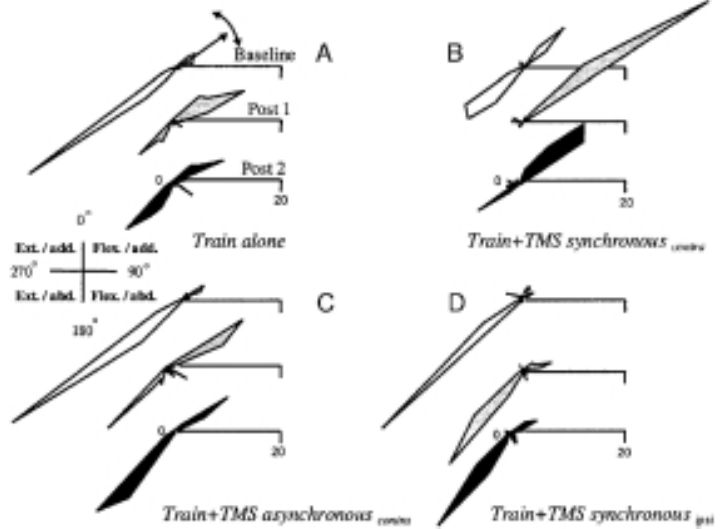
Fig. 3. Effects of Single TMS pulses to M1 (ipsilateral and contralateral to the moving hand) during training on direction of TMS-evoked movements. TMS-evoked movement directions from a single subject displayed as circular histograms at baseline and at two points after training. Mean training angle (arrow) and target training zone for all conditions are shown in A. In the Train alone (A) and Train + TMS asynchronous-contra (C) conditions, TMS-evoked movements at baseline were mainly in the extension/abduction (ext/abd) direction (inset). At post 1, there was a substantial increase in the proportion of TMS-evoked movements in the target training zone (flex/add). After 10–20 min (post 2), most TMS-evoked movements returned to the baseline direction. Note that Train + TMS synchronous-contra (B) elicited a more prominent and longer lasting change and that Train + TMS synchronous-ipsi (D) blocked the training effects. Used with permission from Butefisch et al. 2004